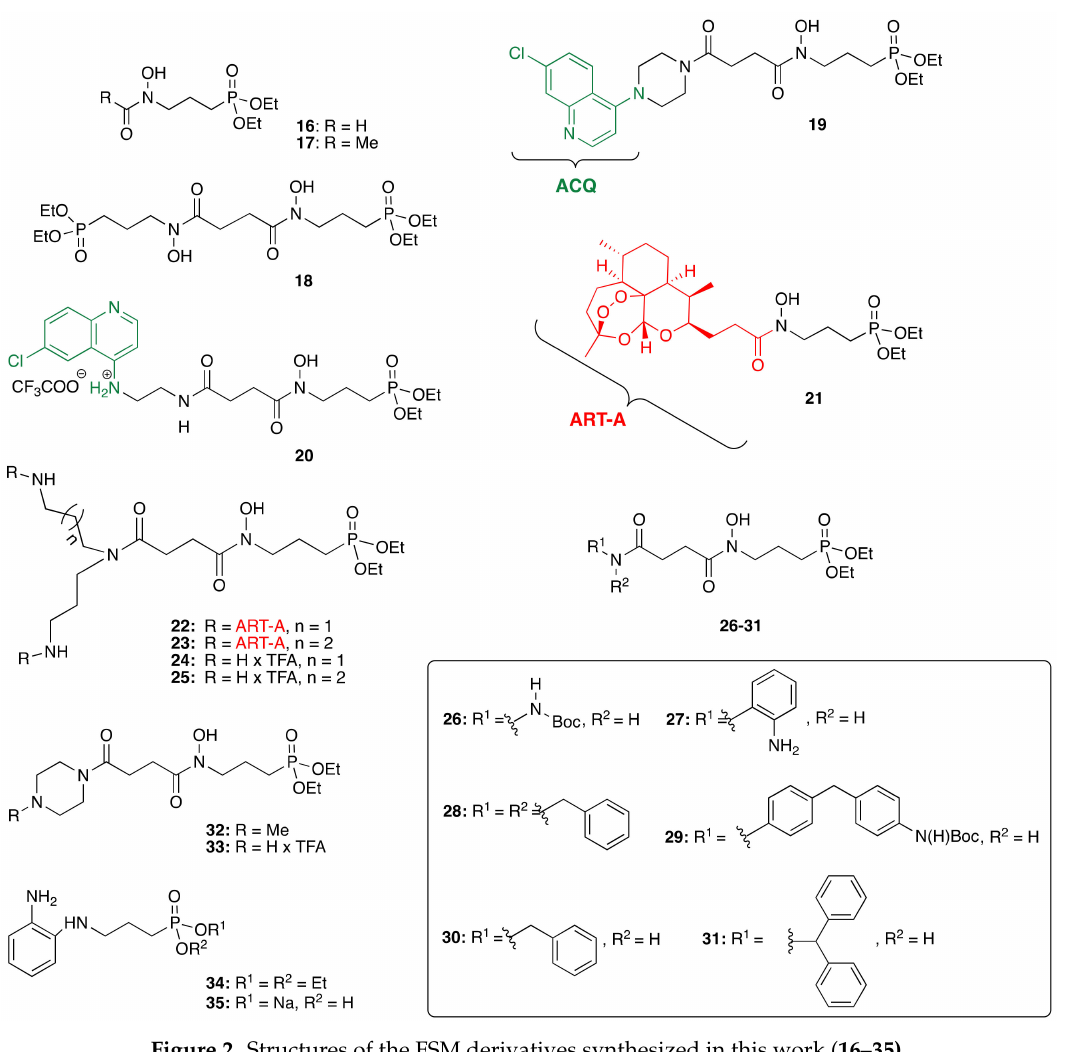
Figure 2. Structures of the FSM derivatives synthesized in this work ( 16 – 35)